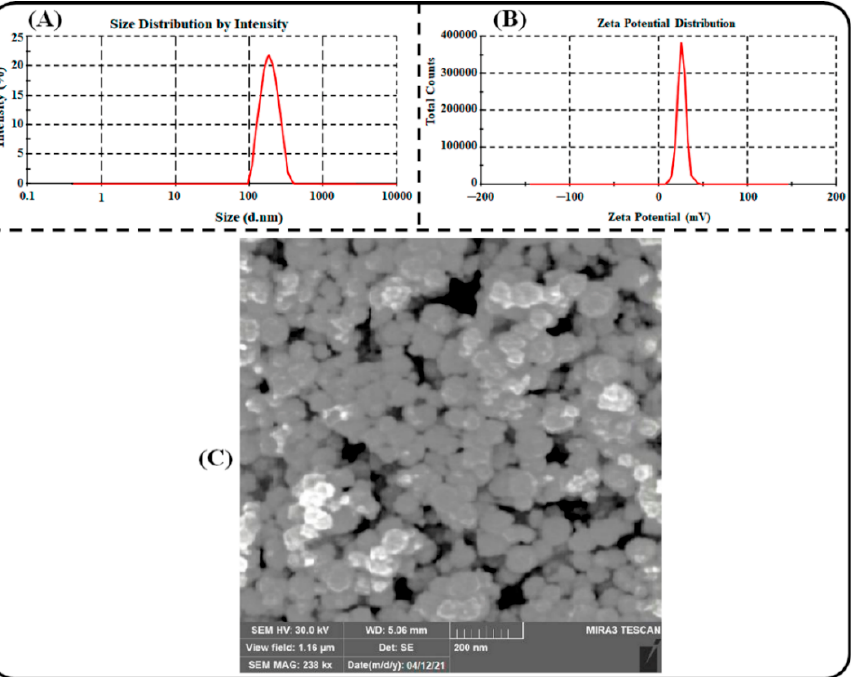
Figure 5. Image representing ( A ) particle size and particle size distribution, ( B ) zeta potential distribution, and ( C ) SEM micrograph of the optimized